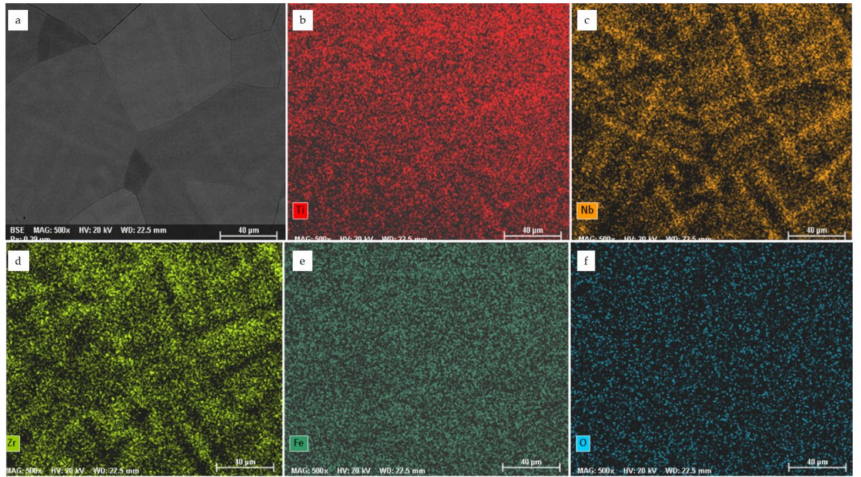
Figure 3. Distribution of alloying elements for the sample Ti29.3Nb13.6Zr1.9Fe in a cast state: ( a ) -SEM-BSE image of the analyzed field; ( b ) -Ti distribution; ( c ) -Nb distribution; ( d ) -Zr distribution; ( e ) -Fe distribution; ( f ) -O